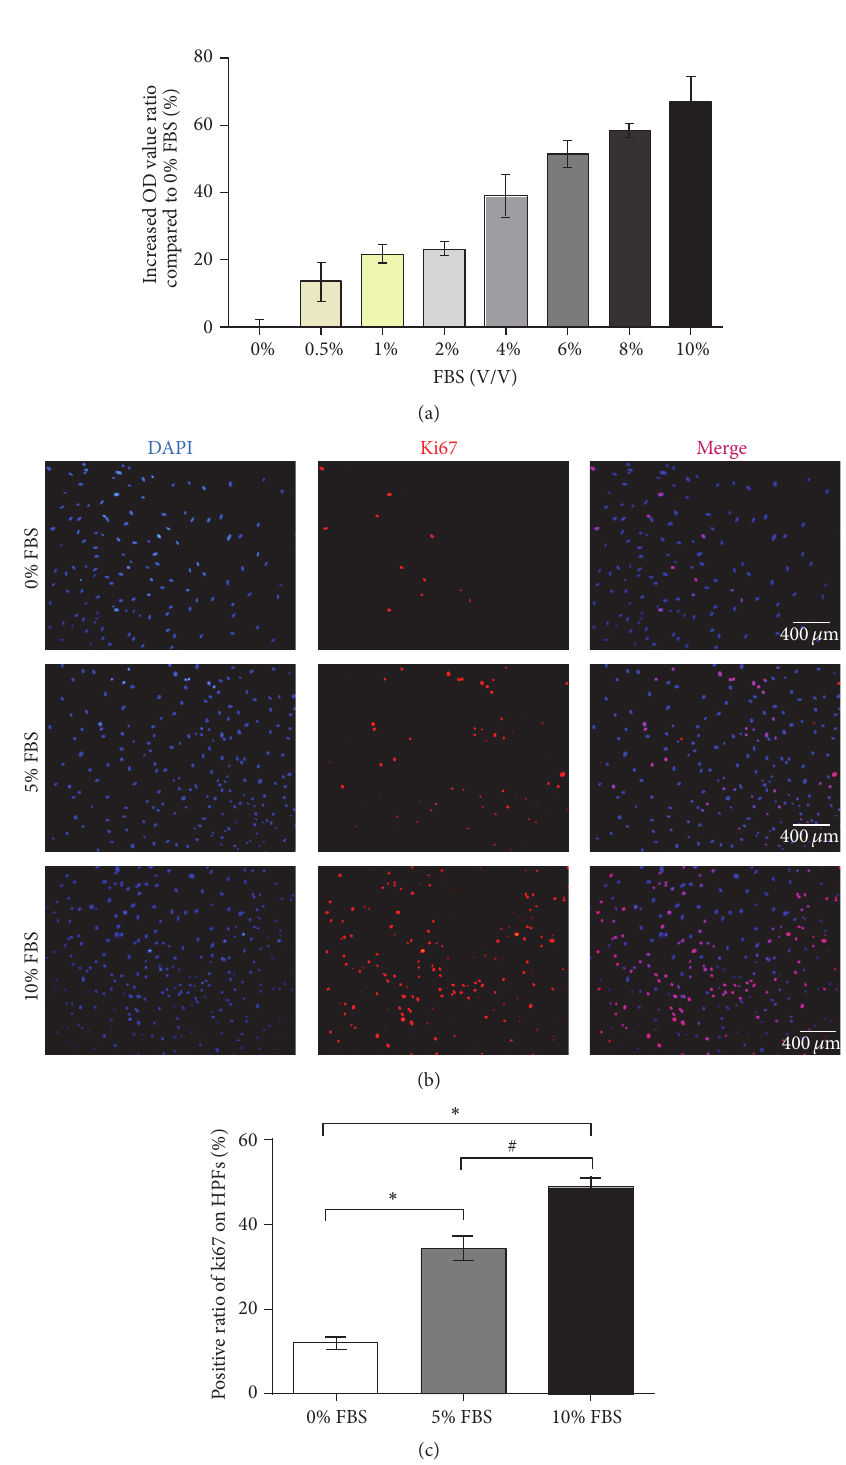
Figure 1: Serum had a strong proliferative effect on HPFs. (a) MTT assay showed serum had a proliferative effect on every concentration from 0.5% FBS to 10% FBS and the effect increased along with increased concentrations of serum. (b) Immunofluorescence staining of ki67 on HPFs in 0% FBS, 5% FBS, and 10% FBS. (c) The positive rate of ki67 on HPFs increased along with increased concentrations of serum. ∗ 𝑃 < 0.05 compared to 0% FBS, # 𝑃 < 0.05 compared to 5%